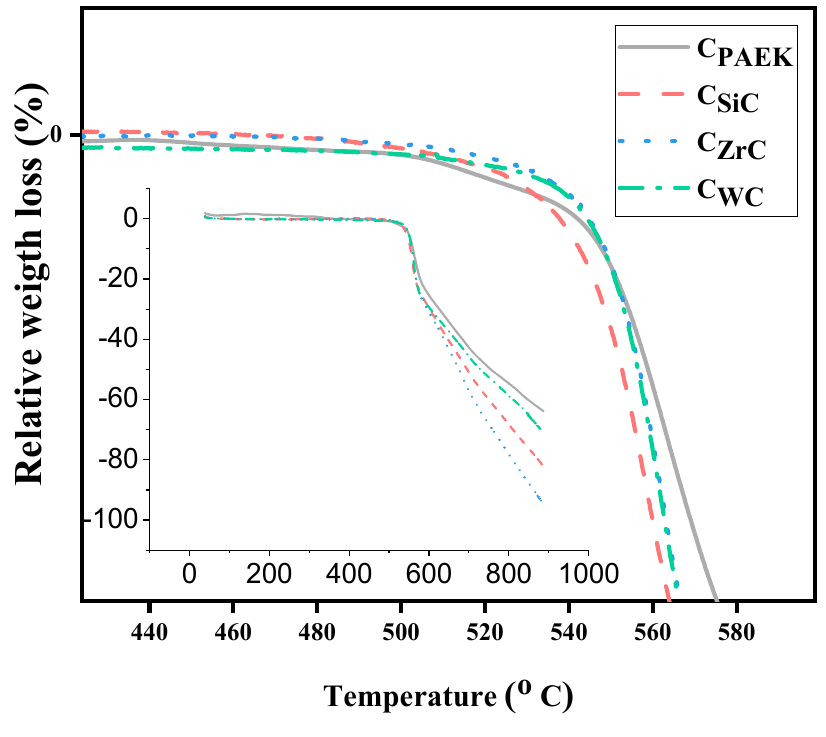
Figure 6. TGA thermograms for NCs. Table 4. T 5 and T 10 for developed composites derived from TGA thermograms.